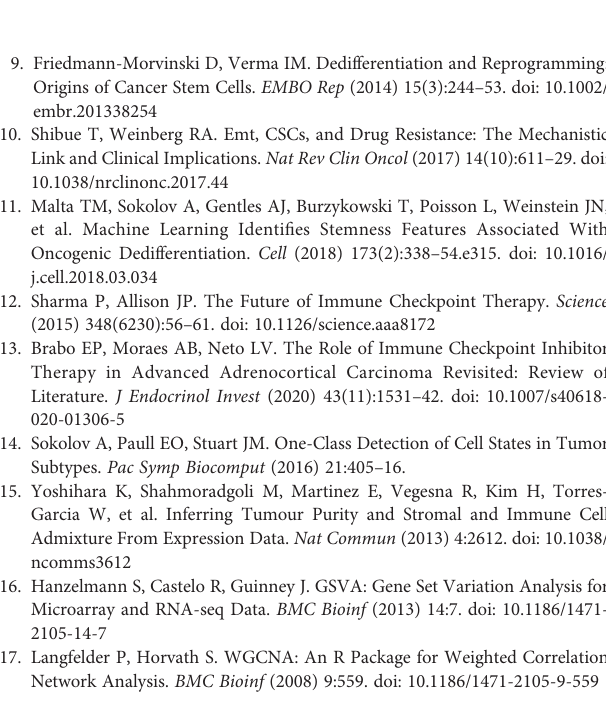
Supplementary Figure 1 | Kaplan – Meier OS curves for 22 hub genes with low and high expression based on the median cutoff point in ACC patients. Supplementary Figure 2 | Kaplan – Meier OS curves for 22 hub genes with low and high expression based on the median cutoff point in ACC patients. Supplementary Table 1 | Wilcoxon rank sum test for the Age, Gender, N stage and M stage, and Dunn ’ s test for the Histological type and T stage. Supplementary Table 2 | The information about clinical features. Supplementary Table 3 | Multivariate cox analysis of mRNAsi and other clinical